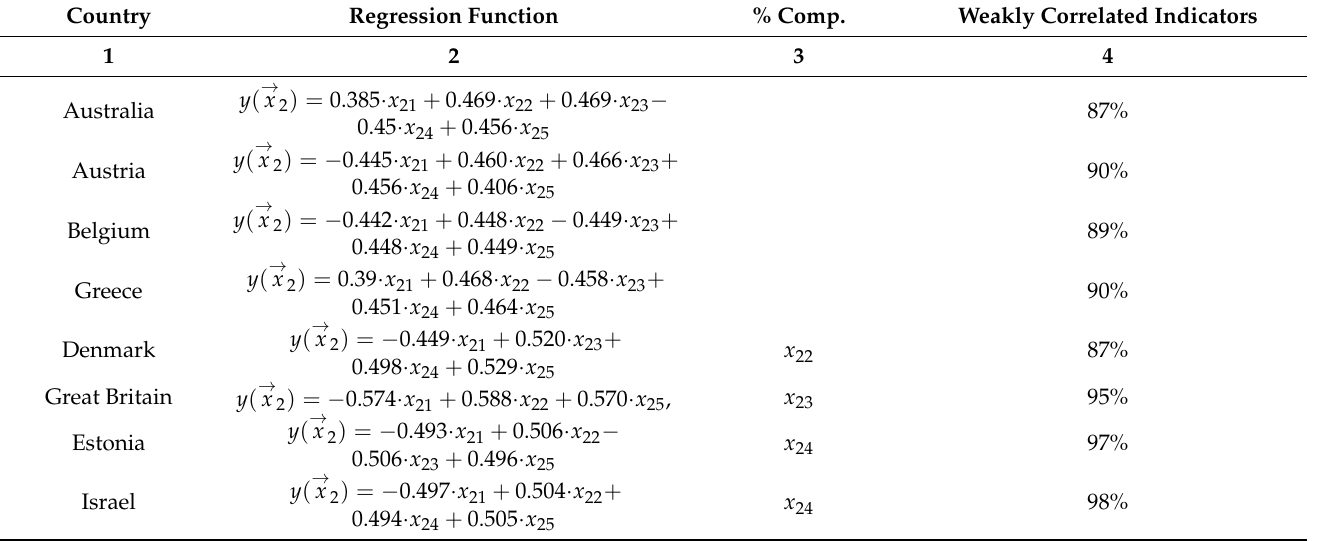
Table 1. Analysis results for the social component of the GICE